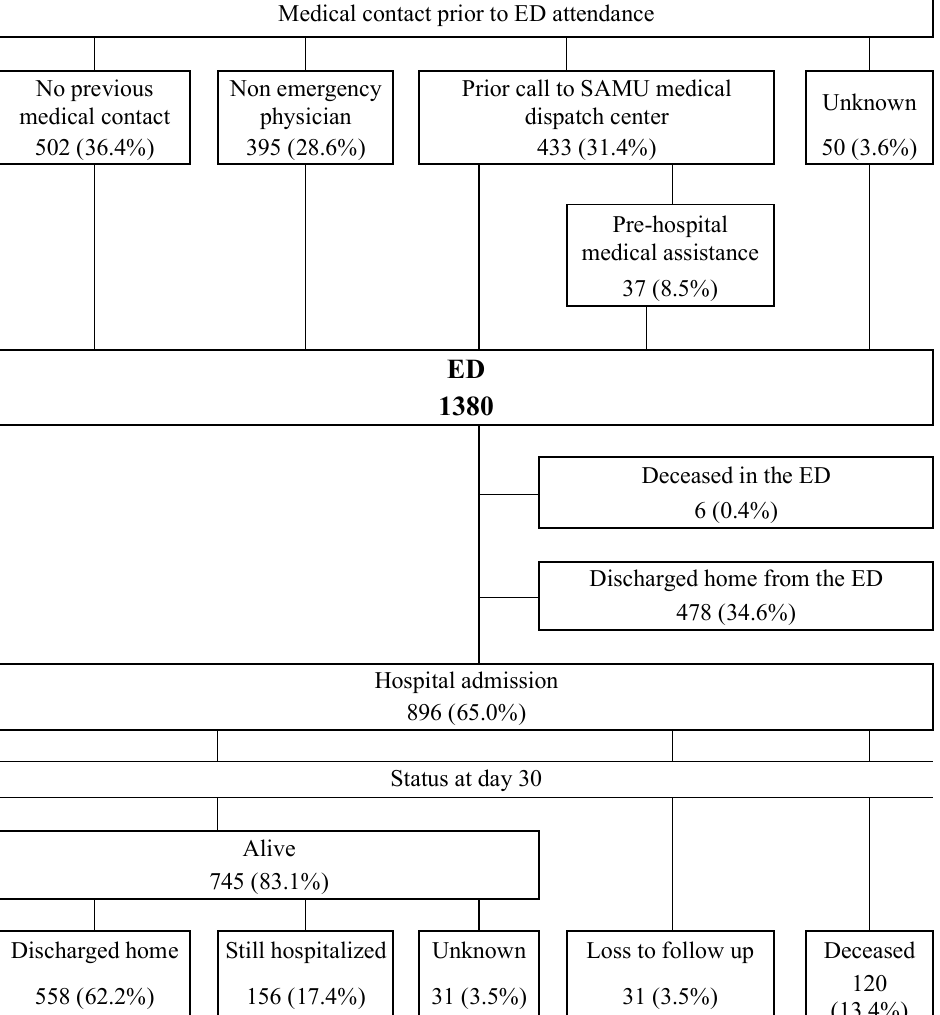
Figure 1. Flowchart of cancer patients attending emergency departments in France throughout the